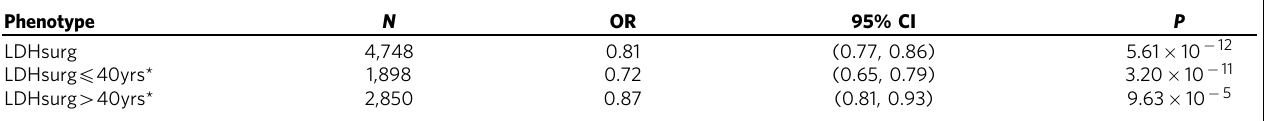
CI, confidence interval; GWAS, genome-wide association studies; LDHsurg, herniated lumbar discs; OR, odds ratio. A w 2 -test was used to compute P